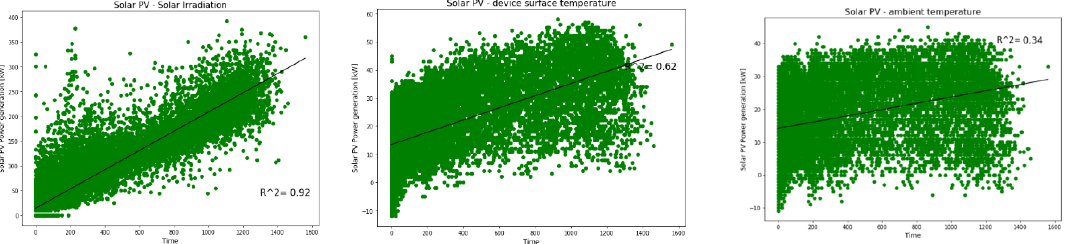
Figure 7. Comparison performance of Pearson’s correlation coefficient between solar photovoltaic generated power (kWh) and three different parameters, with respect to R 2 .